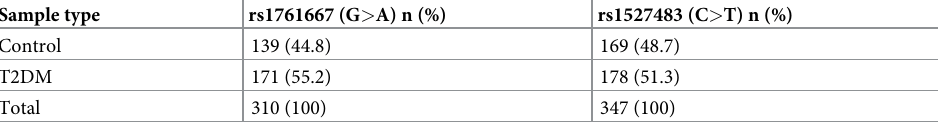
ML tools for both 5-fold cross validation and 20% testing sets based on all input data: lipid pro- file (TG, TC, LDL, and HDL), dyslipidemia status, age, gender, rs1761667 genotype, and Table 2. Frequency distribution of samples used in this study on Jordanian population with CD36 polymorphisms (rs1761667 and